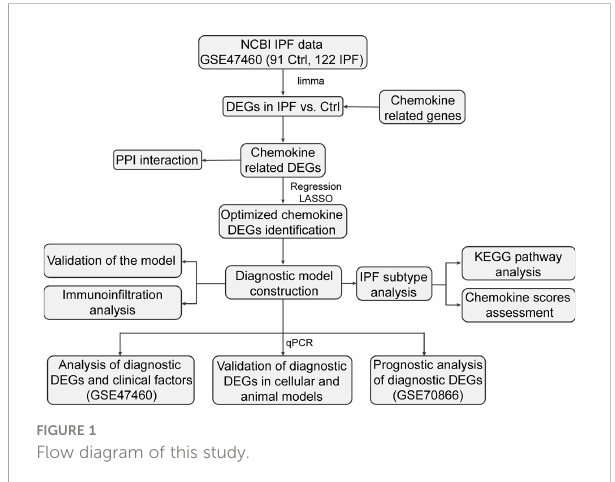
FIGURE 1 Flow diagram of this study.